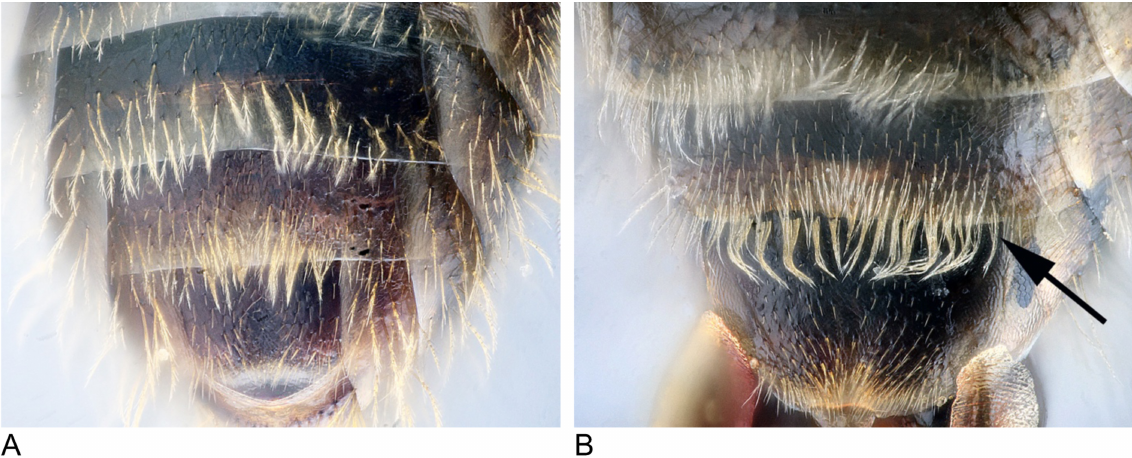
Fig. 21. Fringe on sternum 5 of males (arrow showing the fringe). A . Lasioglossum villosulum (Kirby, 1802). B . L. medinai (Vachal,